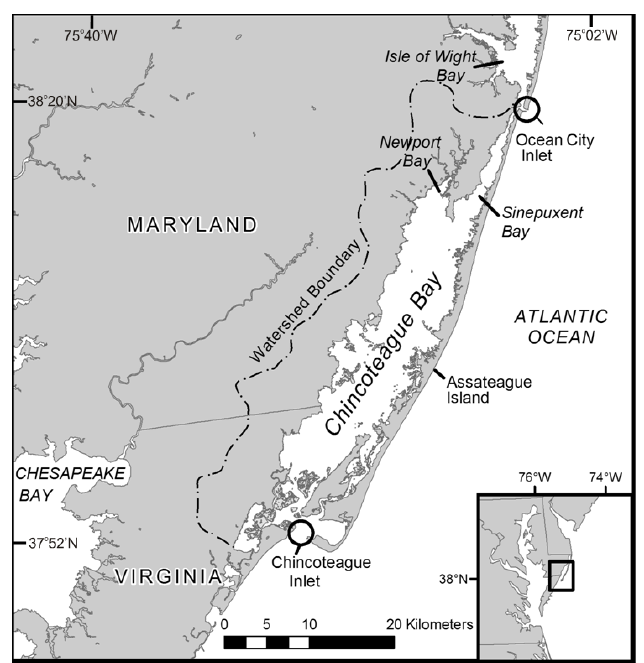
Figure 1. Study area southern Chincoteague Bay and Chincoteague Inlet,